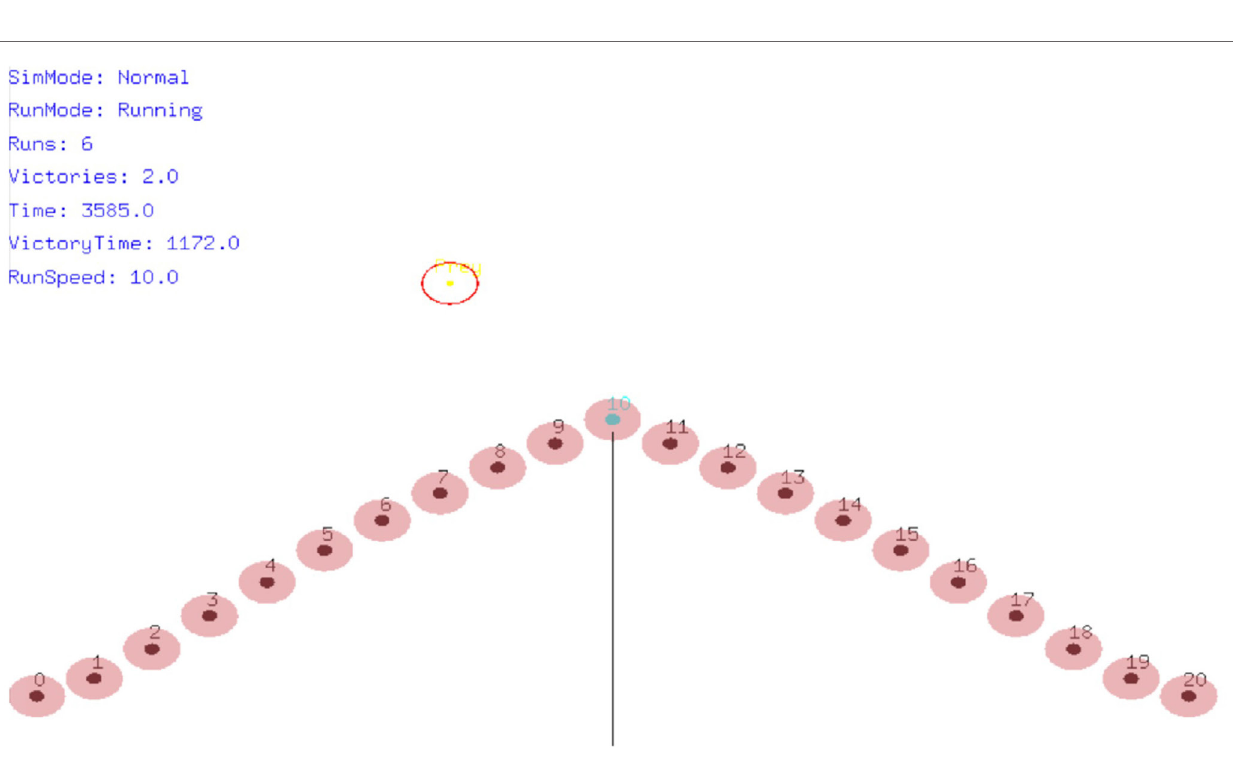
FigUre 9 | loosely coupled chains of arUs (filled circles) are formed to cooperatively search large, connected areas for mobile targets (hollow circle)